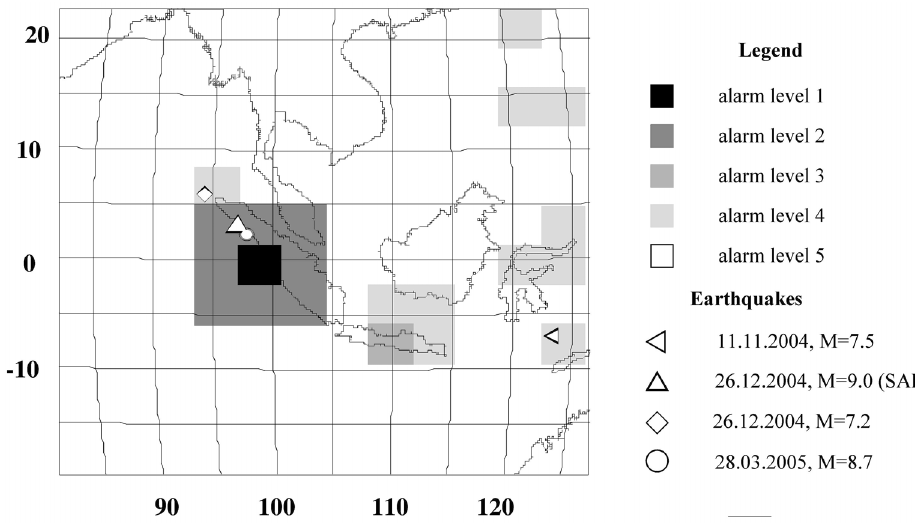
Figure 2. Mapped areas of five levels of half-year forward forecasting for the SAE region on November 10,